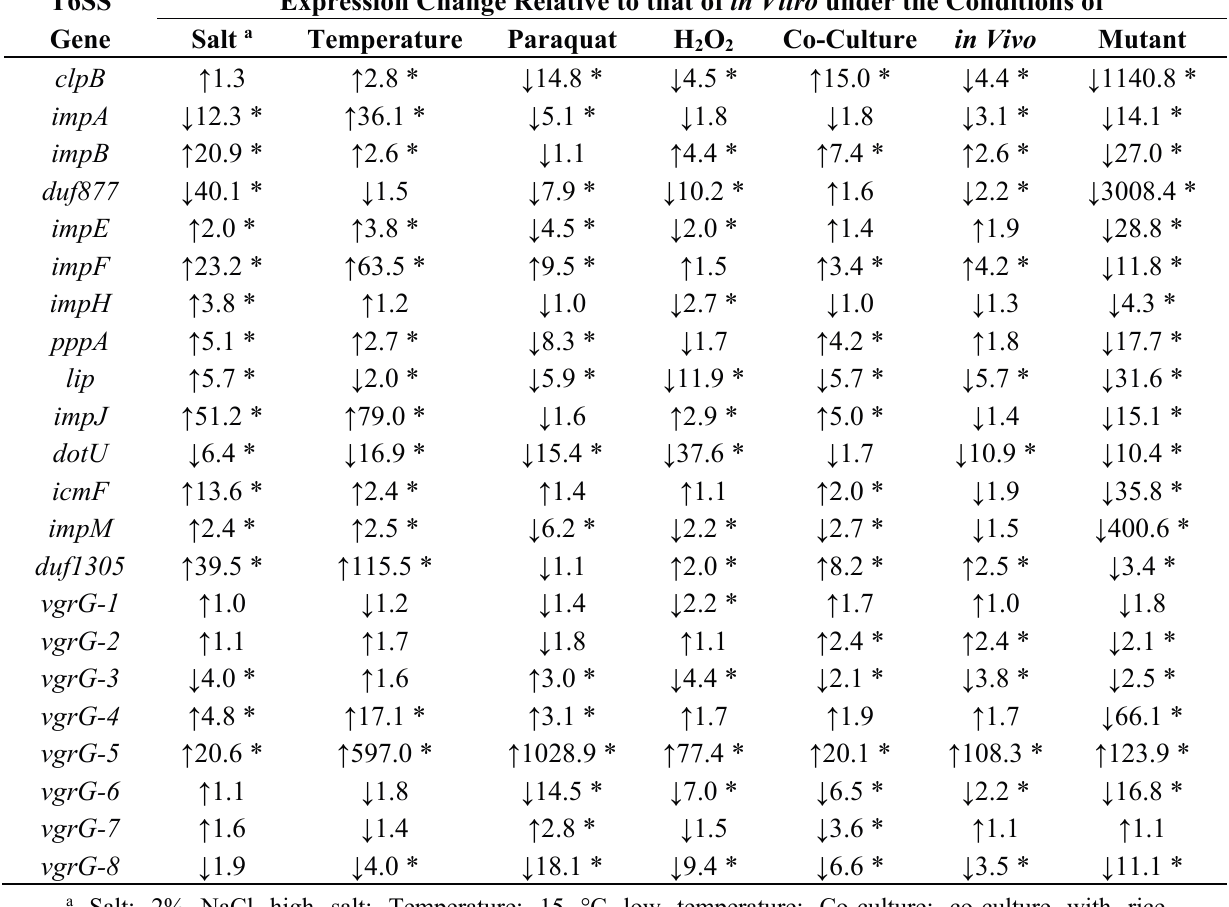
Table 1. Gene expression of T6SS using quantitative real-time PCR in Acidovorax avenae subsp. avenae RS-1 during in vivo rice infection, vgrG- 2 mutant, and co-culture with rice rhizobacterium Burkholderia seminalis R456, as well as high salt, low temperature, H 2 O 2 - and paraquat-mediated oxidative